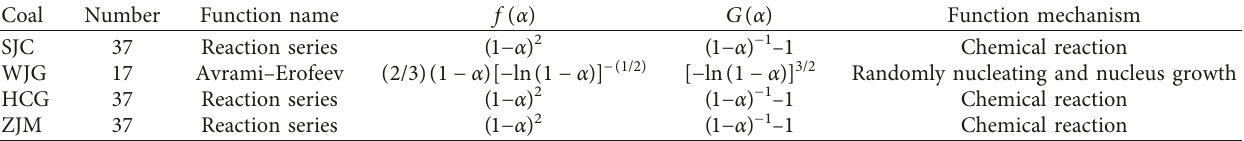
Table 2: The differential form and integral form of mechanism function.